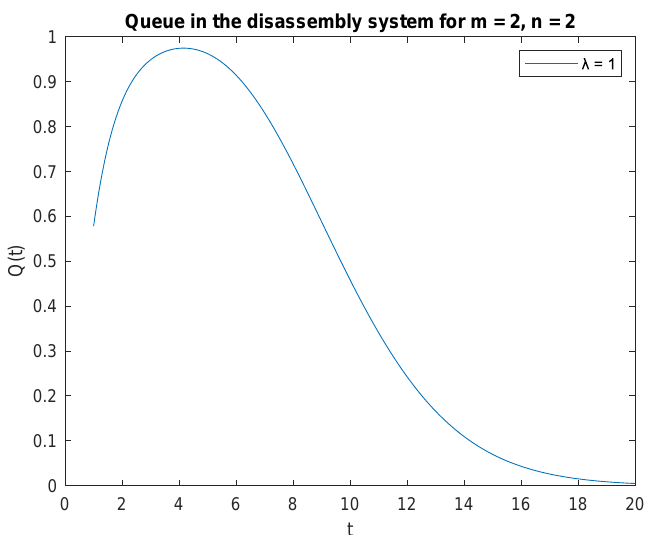
Figure 5. Impact of buffer capacity on probability P { X ( t ) = 2 | X ( 0 ) = 2 }